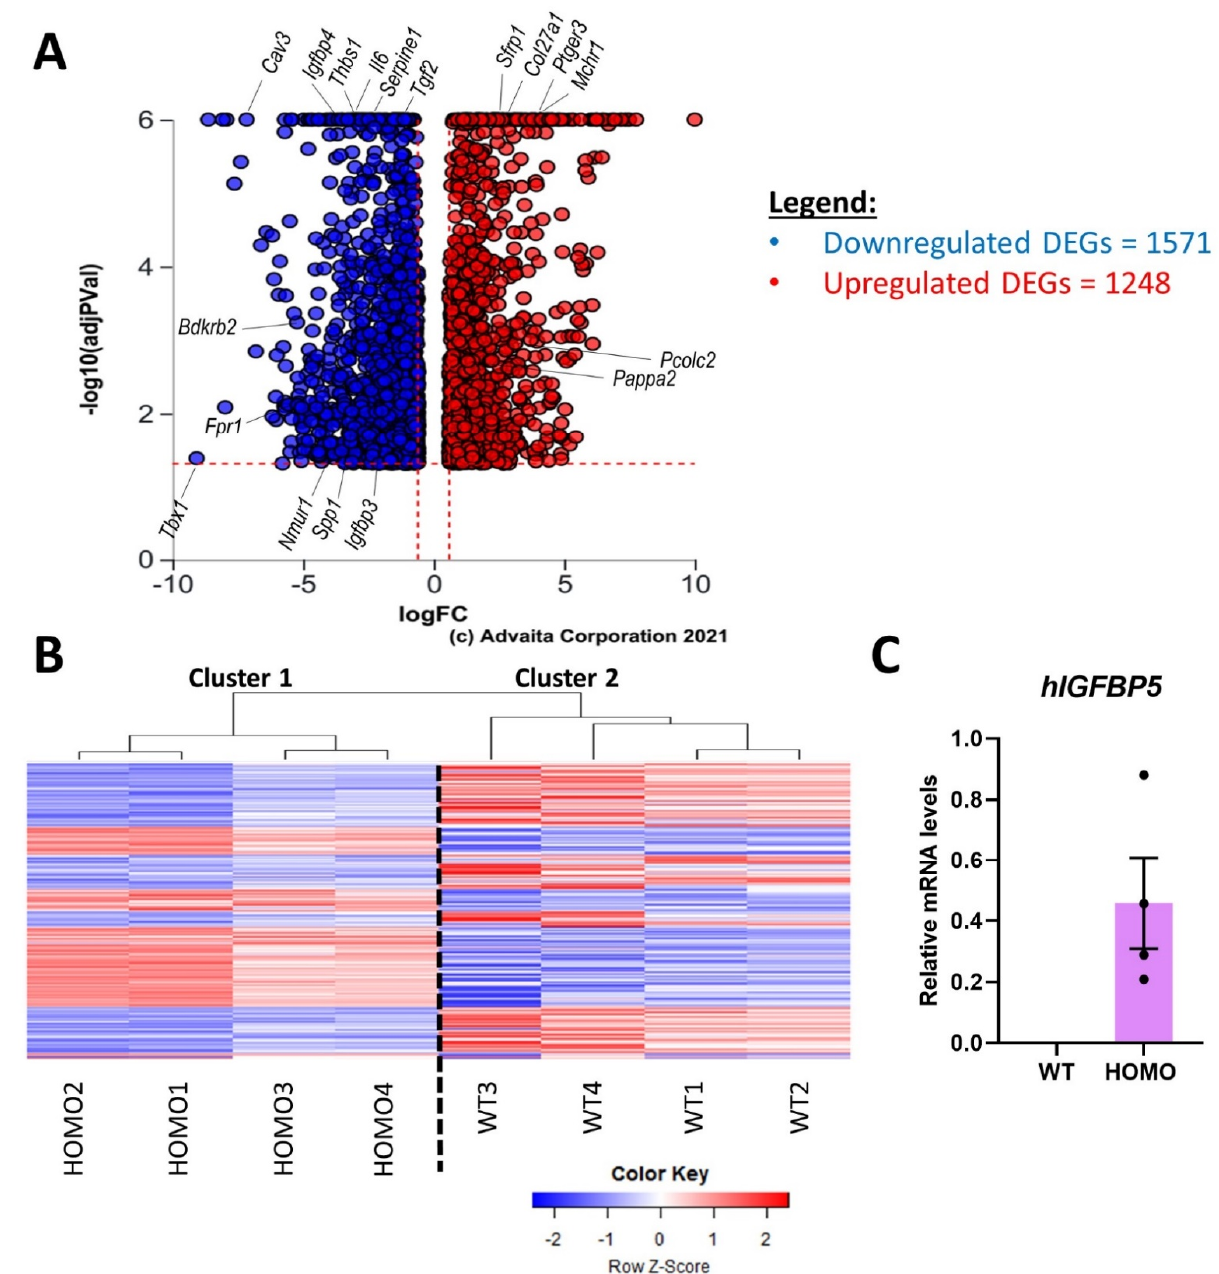
Figure 1. Transcriptomic signature of hIGFBP5 in pFBs. DE analysis comparing “HOMO vs. WT” mice was conducted on DESeq2 and returned 2819 DEGs. ( A ) Volcano plot showing in red DEGs significantly upregulated ( q < 0.05; log2FC > 0.6) and in blue DEGs significantly downregulated ( q < 0.05; log2FC < −0.6). Genes of interest are labelled. ( B ) Heat map of the DEGs in HOMO hIGFBP5 pFBs. Red: up-regulation; Blue: down-regulation. ( C ) Expression levels of transgene human IGFBP5 (h IGFBP5 ) in the fibroblasts of female mice analyzed by RNAseq in panel B. Note that endogenous mouse Igfbp5 was undetectable in the same samples in both WT and HOMO groups (data not shown).